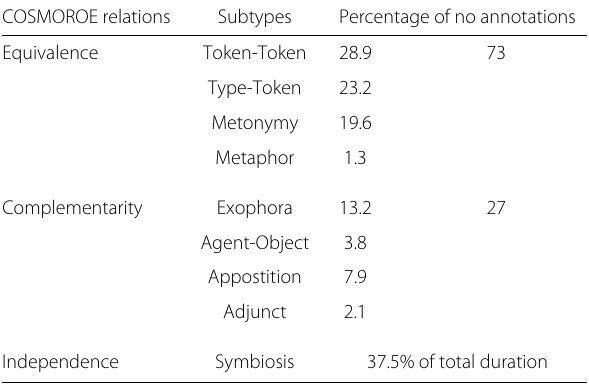
Table 9 Percentage (%) of the COSMOROE cross-media